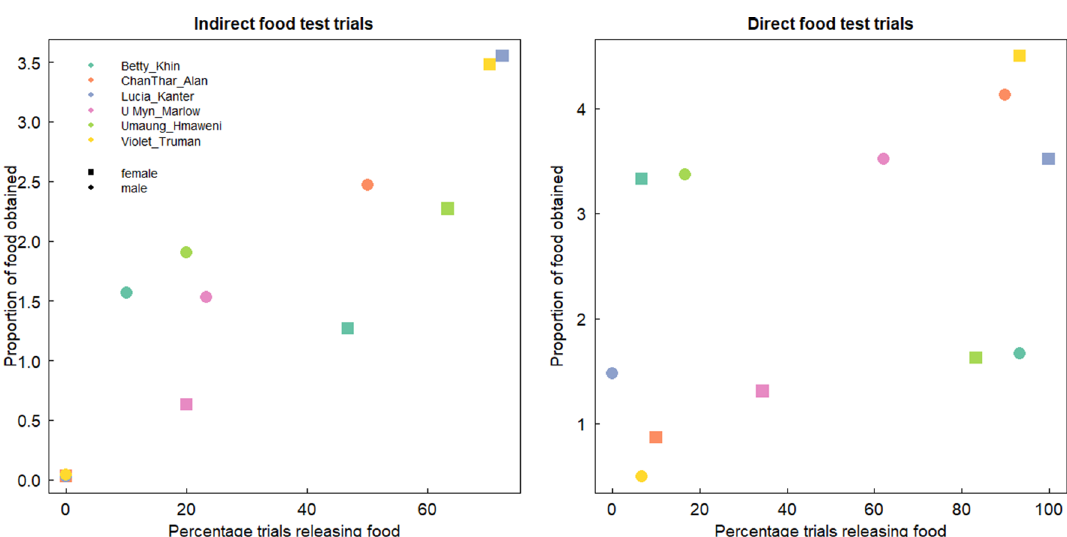
Figure 2. Proportion of food obtained per individual (out of the 5 released rewards) in relation to the percentage of indirect food test trials (left) and direct food test trials (right) in which they released the rewards. Each color represents one dyad. Squares represent females and dots represent